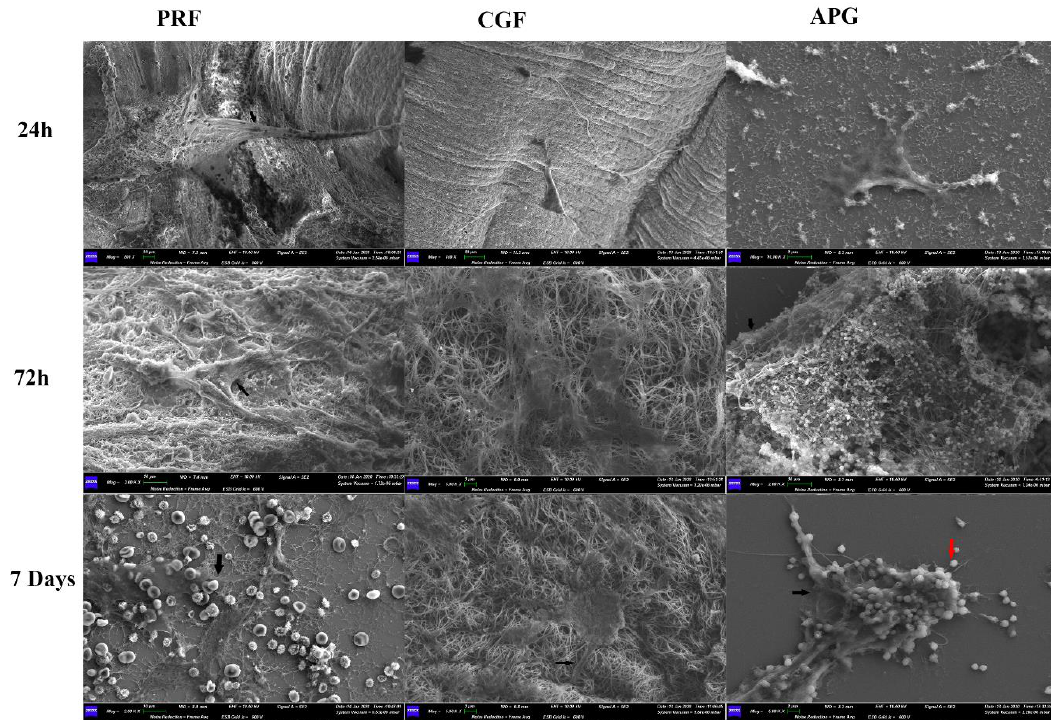
Figure 3. APC representative SEM images showing the morphological reaction of the fibroblasts to the fibrin network, assuming a polygonal shape. Morphological differences of the fibrin networks of the three APCs are evident, with the presence of blood cells with PRF and of platelets with APG. The black arrows indicate the cellular projections toward the biomaterials. The red arrow indicates the platelets in the APG. It is interesting to highlight, in the APG samples, the morphological reaction of the fibroblasts trying to envelop the platelets.